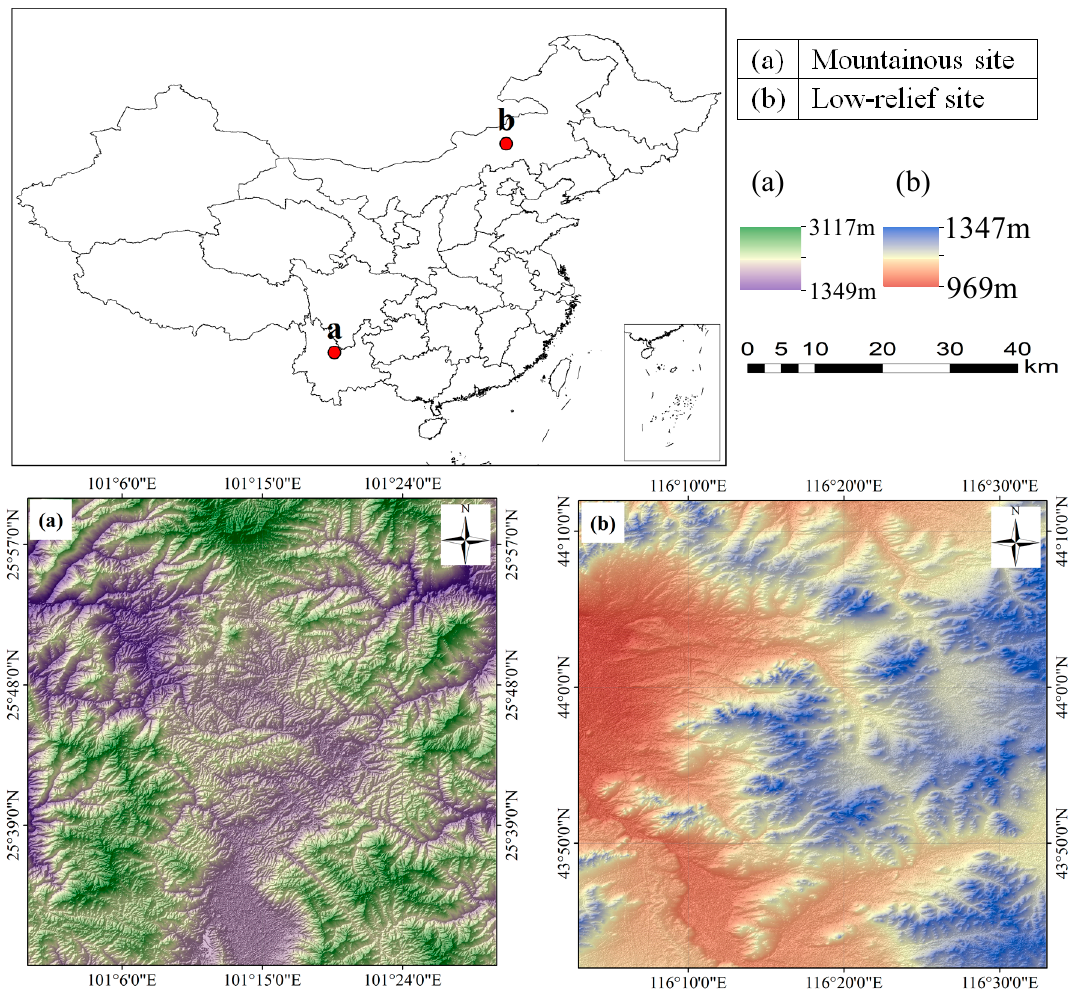
Figure 1. Locations of ( a ) the mountainous site and ( b ) the low-relief site.